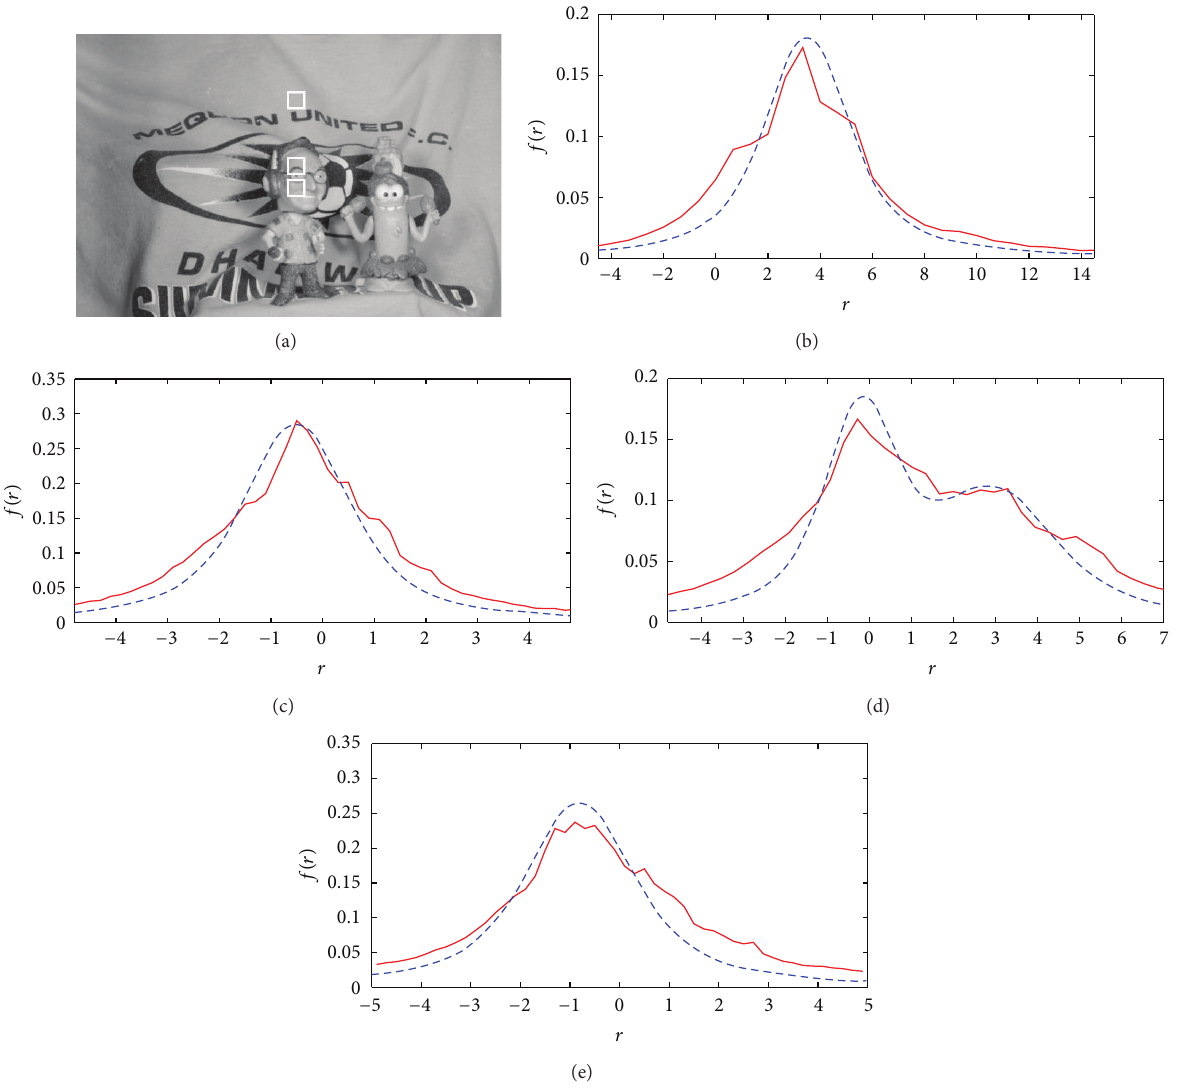
Figure 12: (a) A sample frame of the Mequon image sequence. (b) and (c) Theoretical (dashed) and measured (solid) pdf of 𝑟 for two different patches on two different objects highlighted by white rectangles on the sample frame. (d) and (e) Joint pdf of 𝑟 values for two patches: (d) of two different objects and (e) of the same